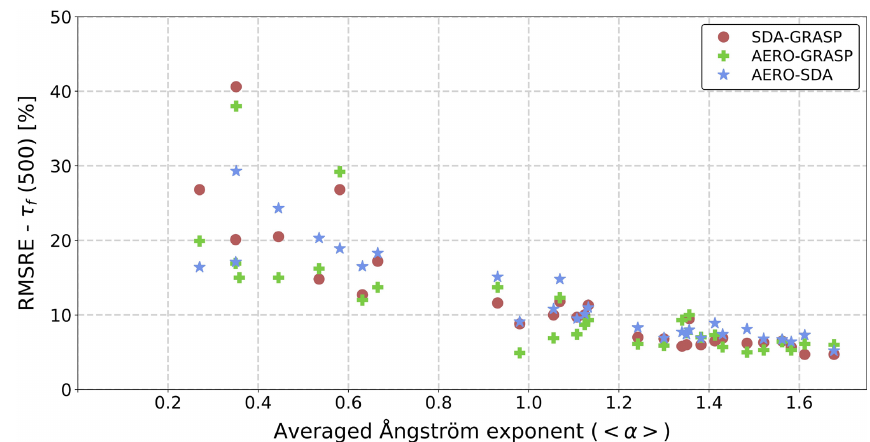
Figure 4. RMSRE from the comparisons of τ f ( 500 ) retrieved by the different methods against the averaged Ångström exponent ( < α > ) for all sites (values can be found in Table 4). RMSRE values between the SDA and GRASP-AOD are represented by red circles, between the AERONET aerosol retrieval algorithm and GRASP-AOD by green crosses, and between the AERONET aerosol retrieval algorithm and SDA by blue